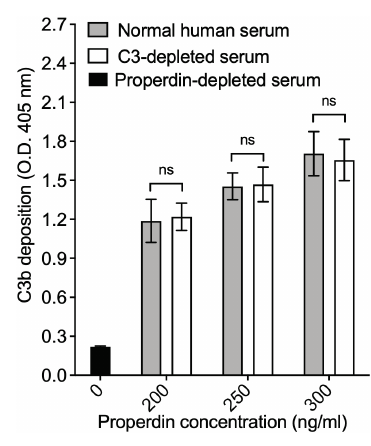
FIGURE 7 Properdin functional ELISA does not capture properdin in combination with C3 components. Properdin function was quanti fi ed by the properdin functional ELISA where the readout is C3b deposition as described in “ Materials and Methods ” section 2.8.2. Data is graphed minus background of samples containing no properdin during the properdin capture step. All samples were tested at equivalent concentrations (200- 300 ng/ml). Results are shown as mean and standard deviation of two independent experiments with triplicates. Signi fi cant differences in C3b deposition between samples was assessed by two-way ANOVA with Bonferroni post hoc test where p ≥ 0.05 non-signi fi cant